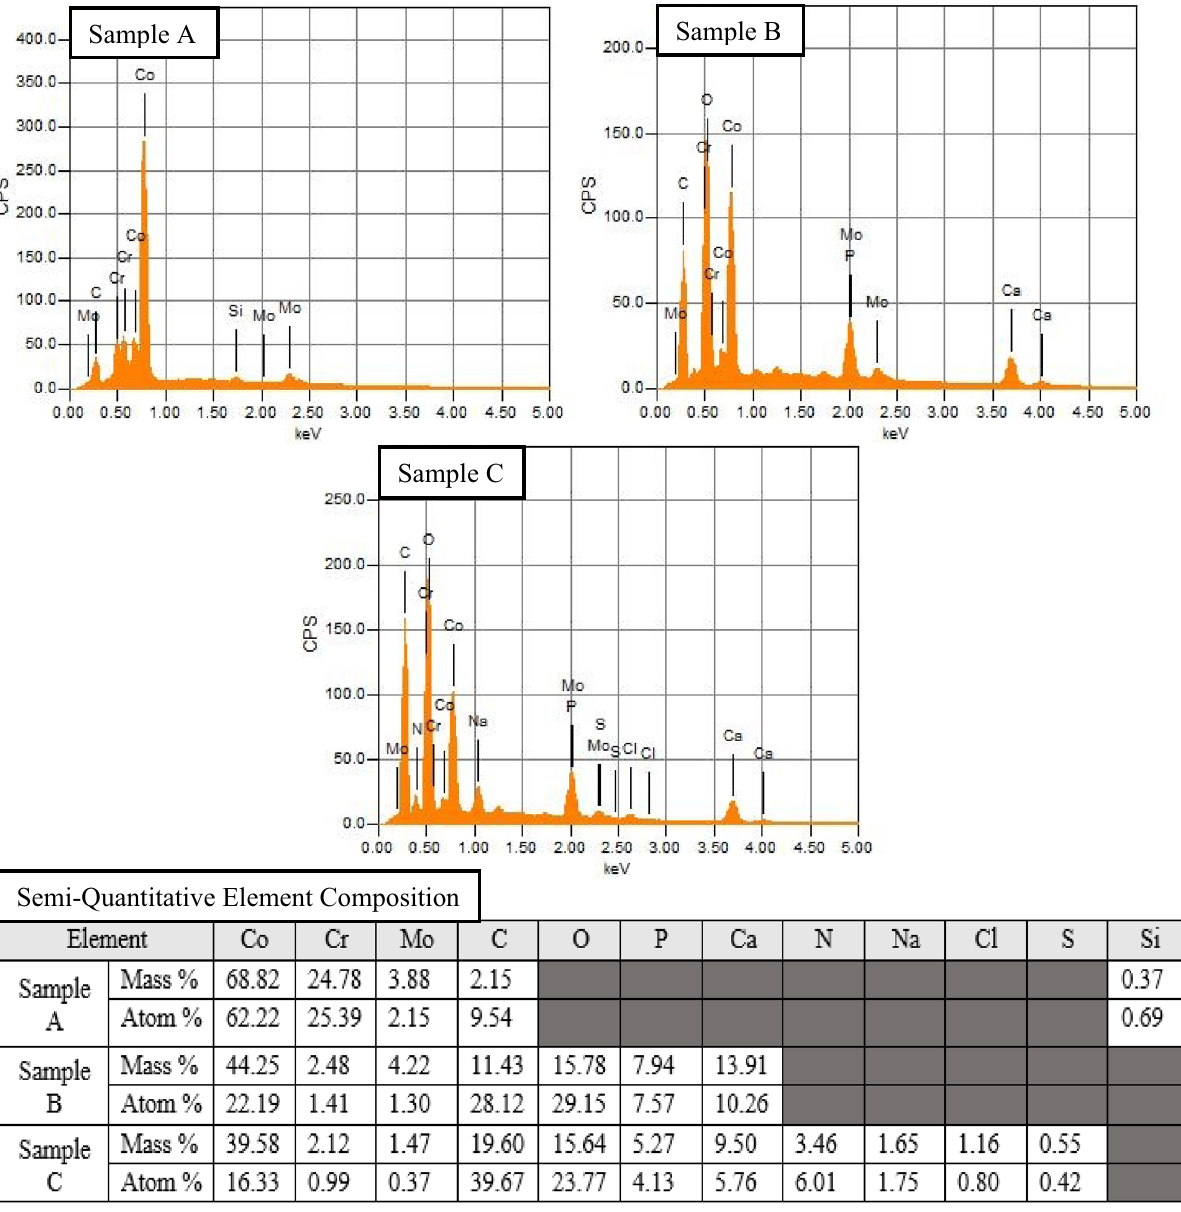
Figure 4. Energy spectrum images and semi- quantitative elemental analysis table from EDS. Elemental spectrum and semi-quantitative analysis arising from EDS analysis. Sample A, shielded from electrical activity, shows little elemental change from the base alloy. Sample B, subjected to a 50 MHz, 200 mVpp sine wave, shows significant surface modification. Sample C, subjected to a 25 MHz, 200 mVpp square wave, shows the greatest variation in elemental composition. Semi-Quantitative Element Composition table shows the mass percentage and atom percentage composition of each element arising from the energy spectrum. *Note: quantitative EDS may not be accurate for light elements such as C and O, therefore in the manuscript it is labeled as semi-